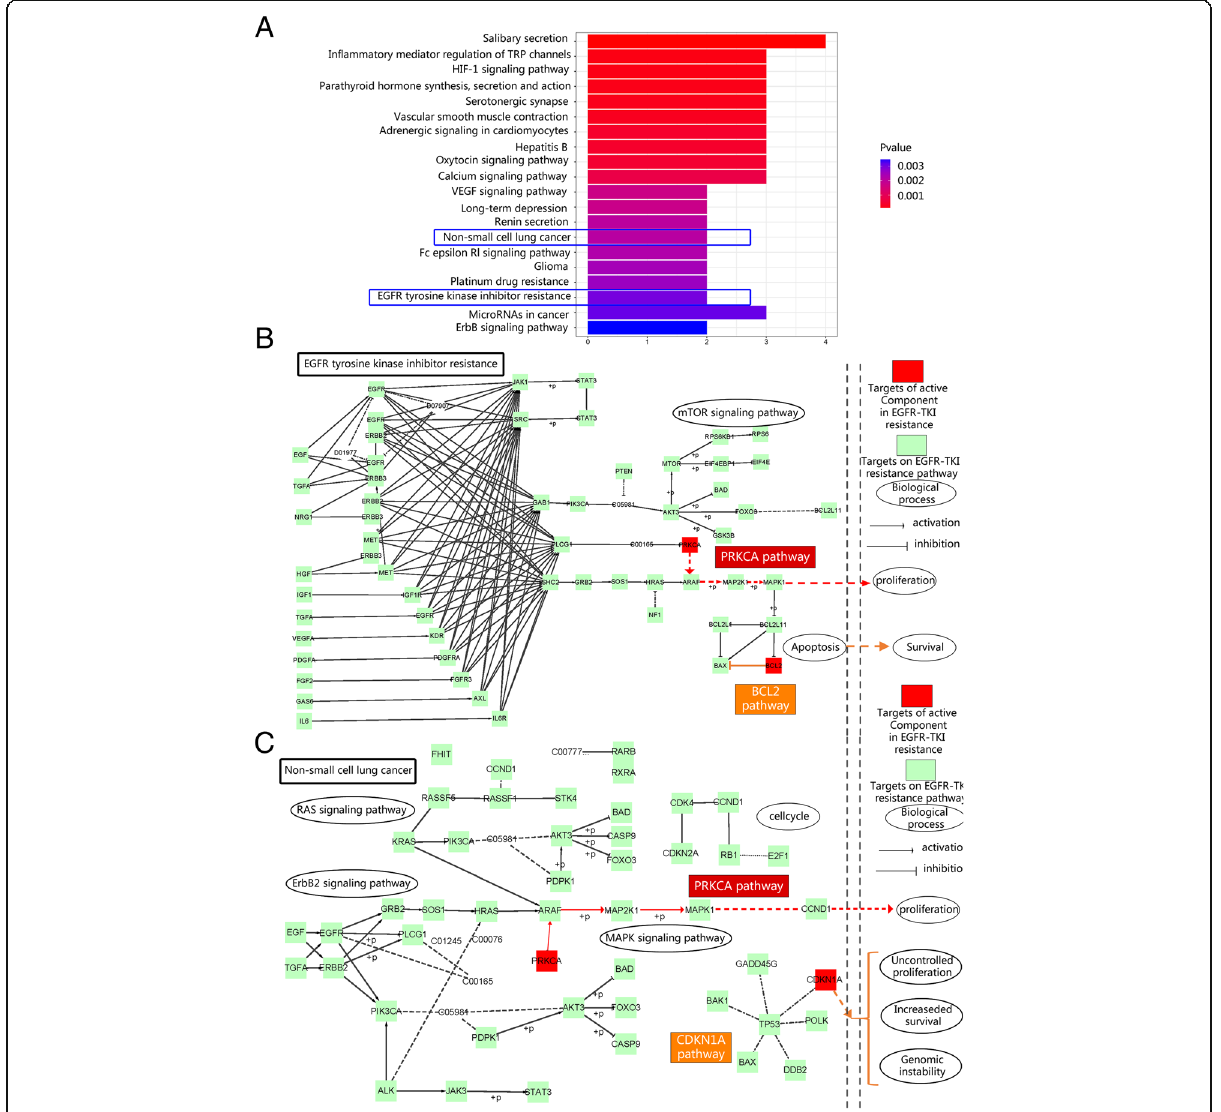
Fig. 6 KEGG enrichment of core genes. a KEGG pathway enrichment of core genes. b . EGFR tyrosine kinase inhibitor resistance pathway. c Non-small cell lung cancer